Question: Looking at the figure, what chart type is it?
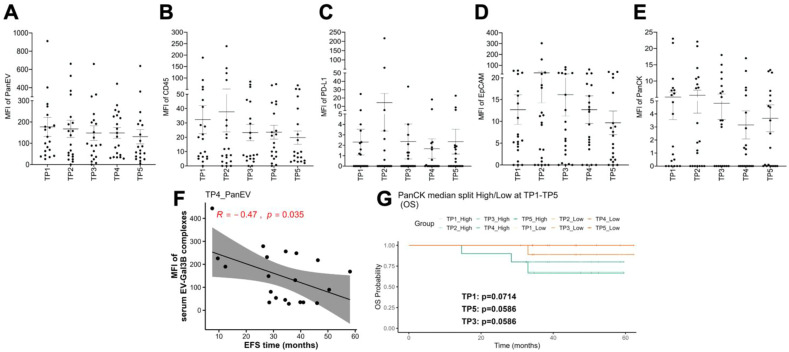
Answer: survival